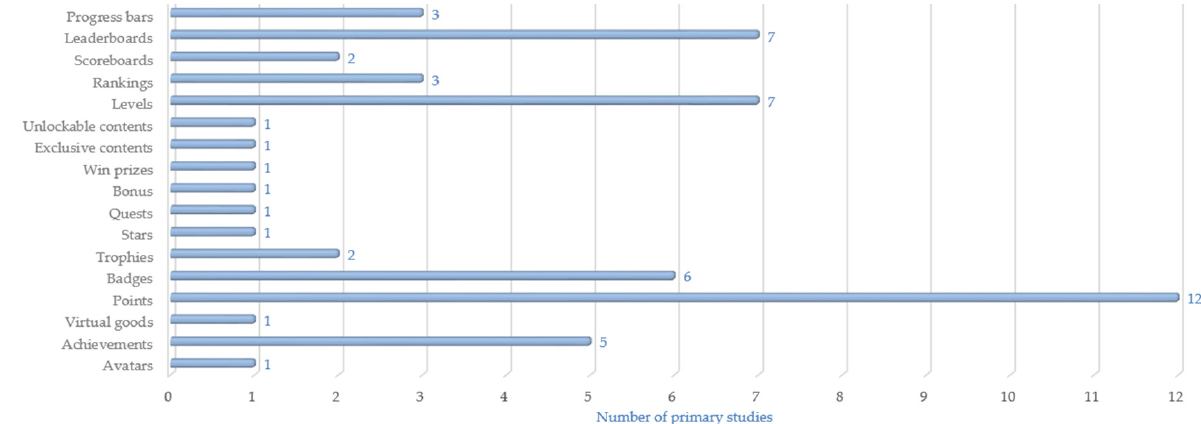
Figure 7. Number of primary studies by game components.